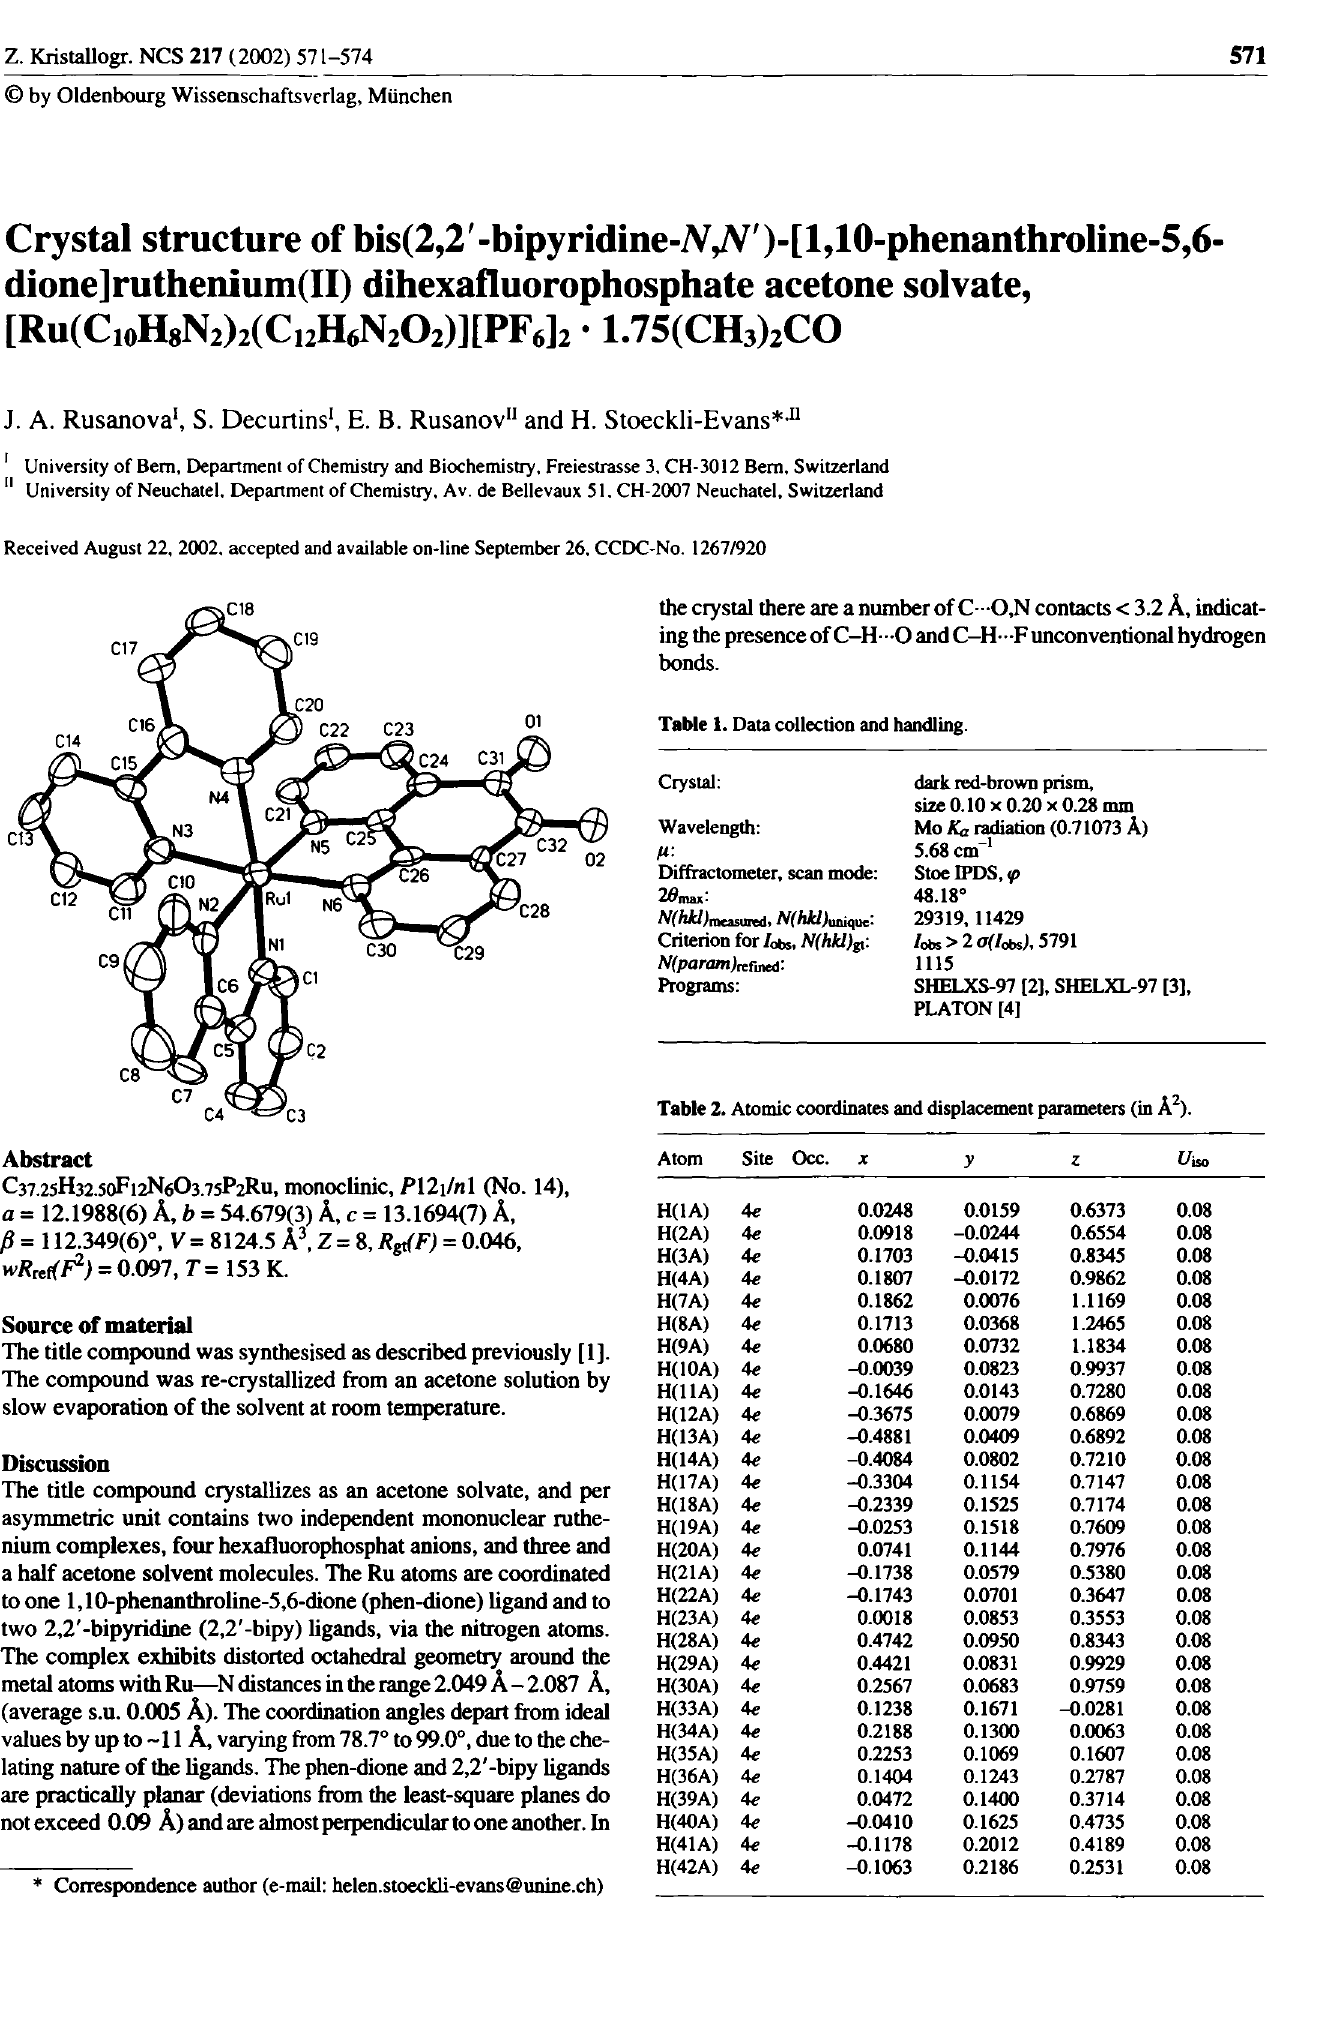
Table 2. Atomic coordinates and displacement parameters (in Â 2